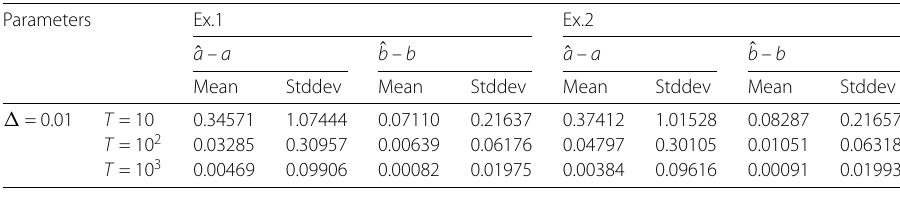
Table 1 Mean and standard deviation of the estimators Parameters